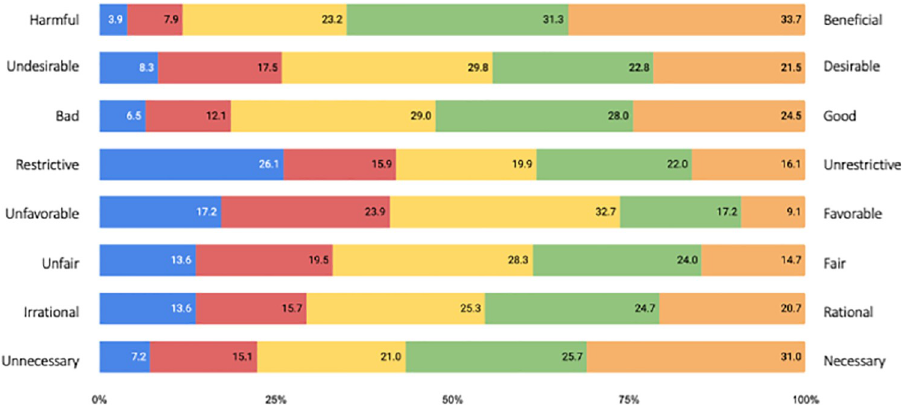
Fig 1. Shares of responses on attitudes toward the protective measures’ directives: "I think recommended protective instructions given by government and health institutions are ... " .